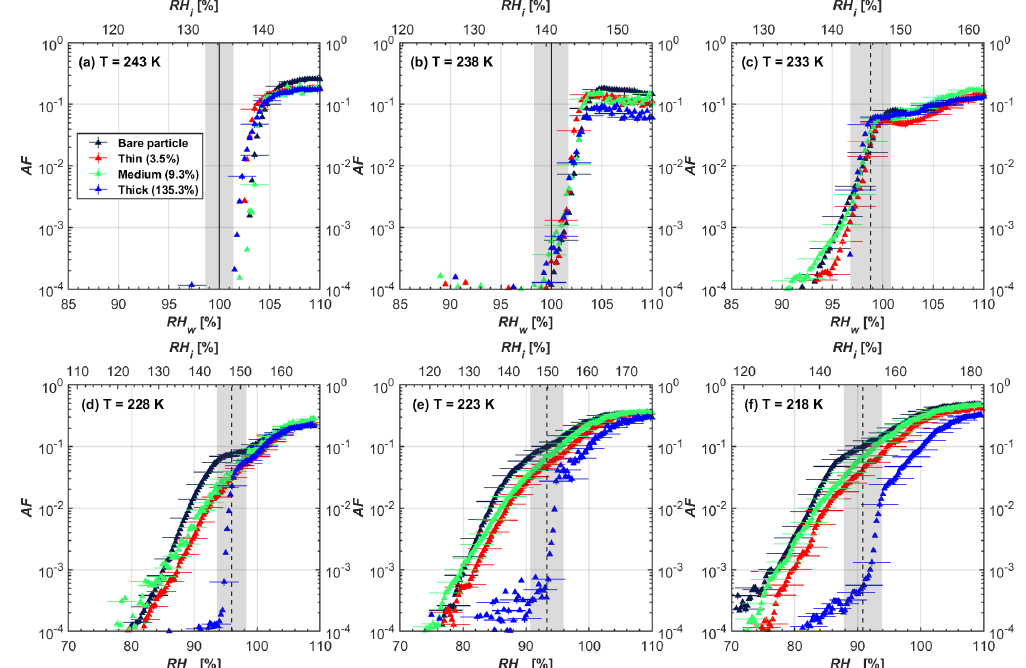
Figure 6. AF as a function of RH at the given temperatures for 200nm FW200 soot particles. Black solid lines represent water saturation conditions according to Murphy and Koop (2005). Black dashed lines denote the expected RH values for solution droplet homogeneous freezing at T < HNT (Koop et al., 2000). The grey-shaded area shows the possible RH variation and uncertainty in HINC for the calculated water saturation and homogeneous freezing conditions. The percentages represent the H 2 SO 4 coating